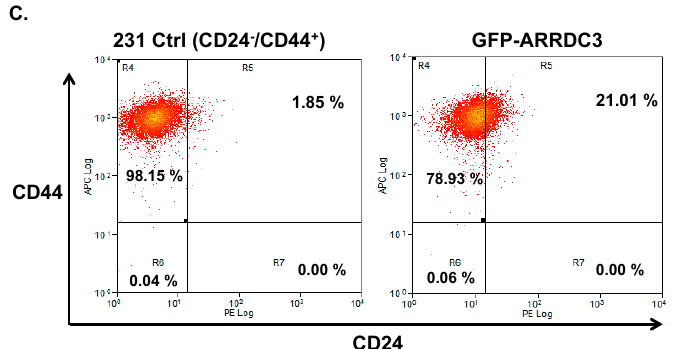
Figure 1. ARRDC3 reverses chemo-resistance to DNA damaging agents in mesenchymal subtype of TNBC cells. ( A ) MDA-MB-231 cells transfected with ARRDC3 cDNA were treated with 5-FU (20 μ M) for 48 h ( + : presence; − : absence). Cell cytotoxicity was evaluated by crystal violet staining